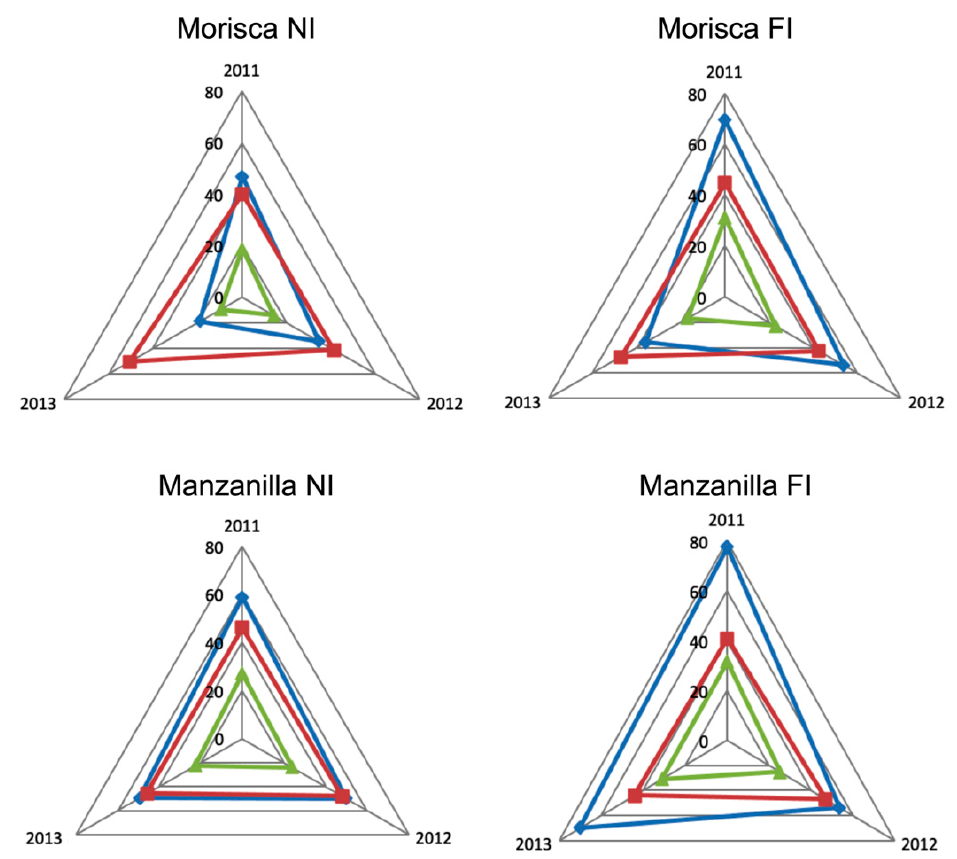
Figure 1. The olive fruit yield (kg ha − 1 × 100) – ♦ –, oil concentration (% DW) – ■ – and yield (kg ha − 1 × 100) – ▲ – in the varieties Morisca and Manzanilla, for rainfed (NI) and irrigated (FI) water regimes, during the three seasons studied (2011, 2012, 2013)—derived from Table S2.